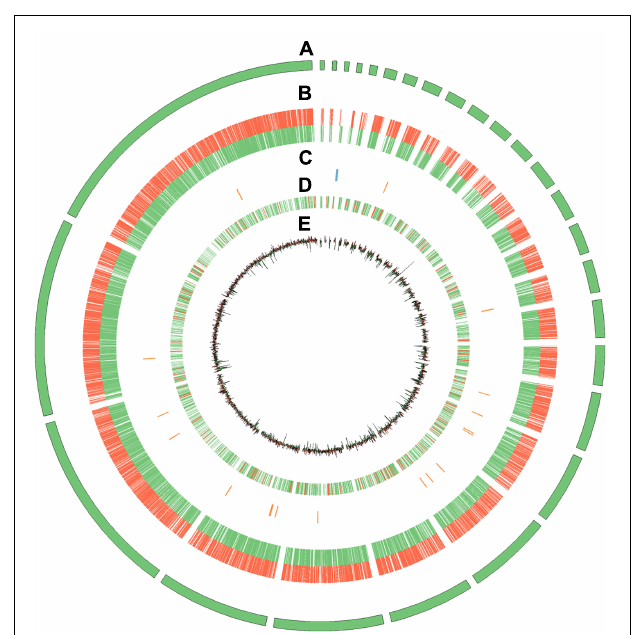
FIGURE 1 | The general view of P. tuber-regium genome. (A) Contigs longer than 100 kb. (B) Gene density, represented as the number of genes in 100 kb non-overlapping windows. (C) Distribution of rRNA, tRNA, snRNA, and snoRNA. (D) Distribution of coverage of repetitive sequences. (E) GC content, increased in color from green to